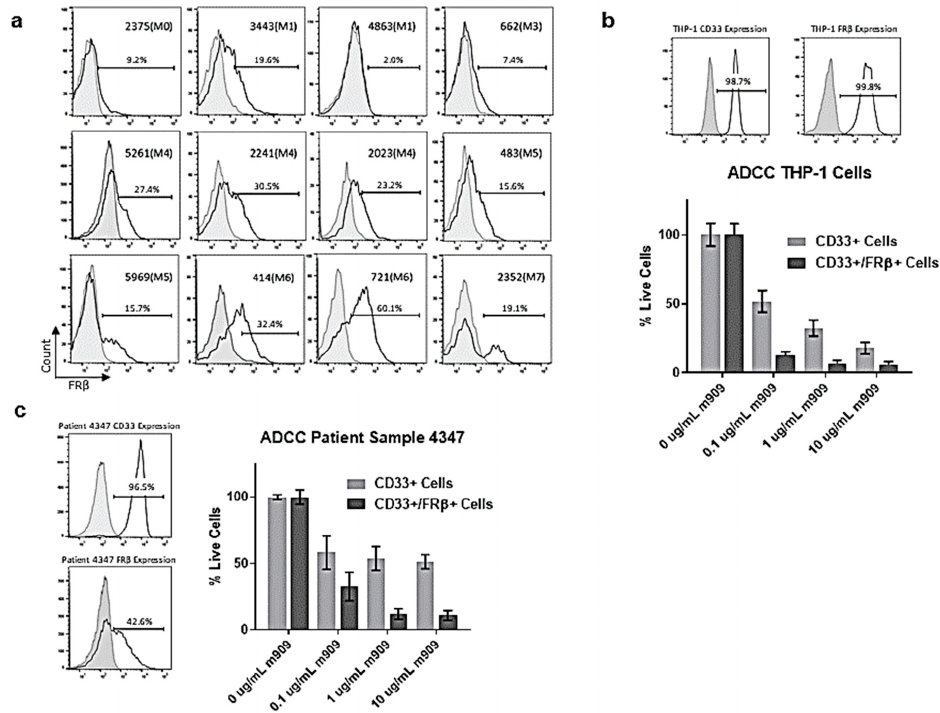
Figure 3. Activity of m909 against primary patient AML samples. ( a ) FR β expression on patient samples with various subtypes of AML. ( b ) Expression of CD33 and FR β in THP-1 cells and ADCC by flow using THP-1 cells demonstrates efficacy with dose-dependent response. ( c ) CD33 and FR β expression data for patient sample 4347. ADCC data for patient sample 4347 showing average from two separate experiments with triplicate samples. All graphs were normalized to wells with 0 µ g/mL of m909. Error bars represent standard